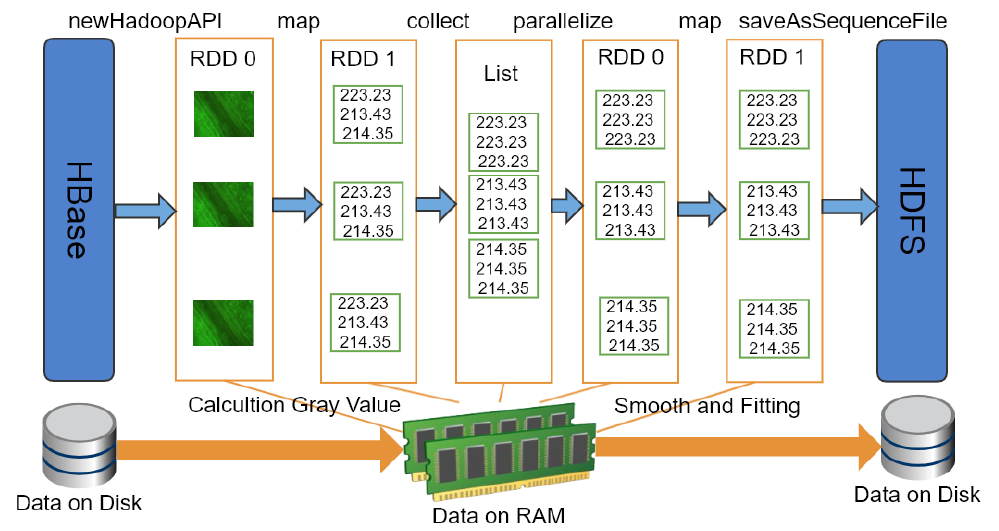
Figure 5. The plant electrical signals extraction process from plant fluorescence image series based on on Spark.